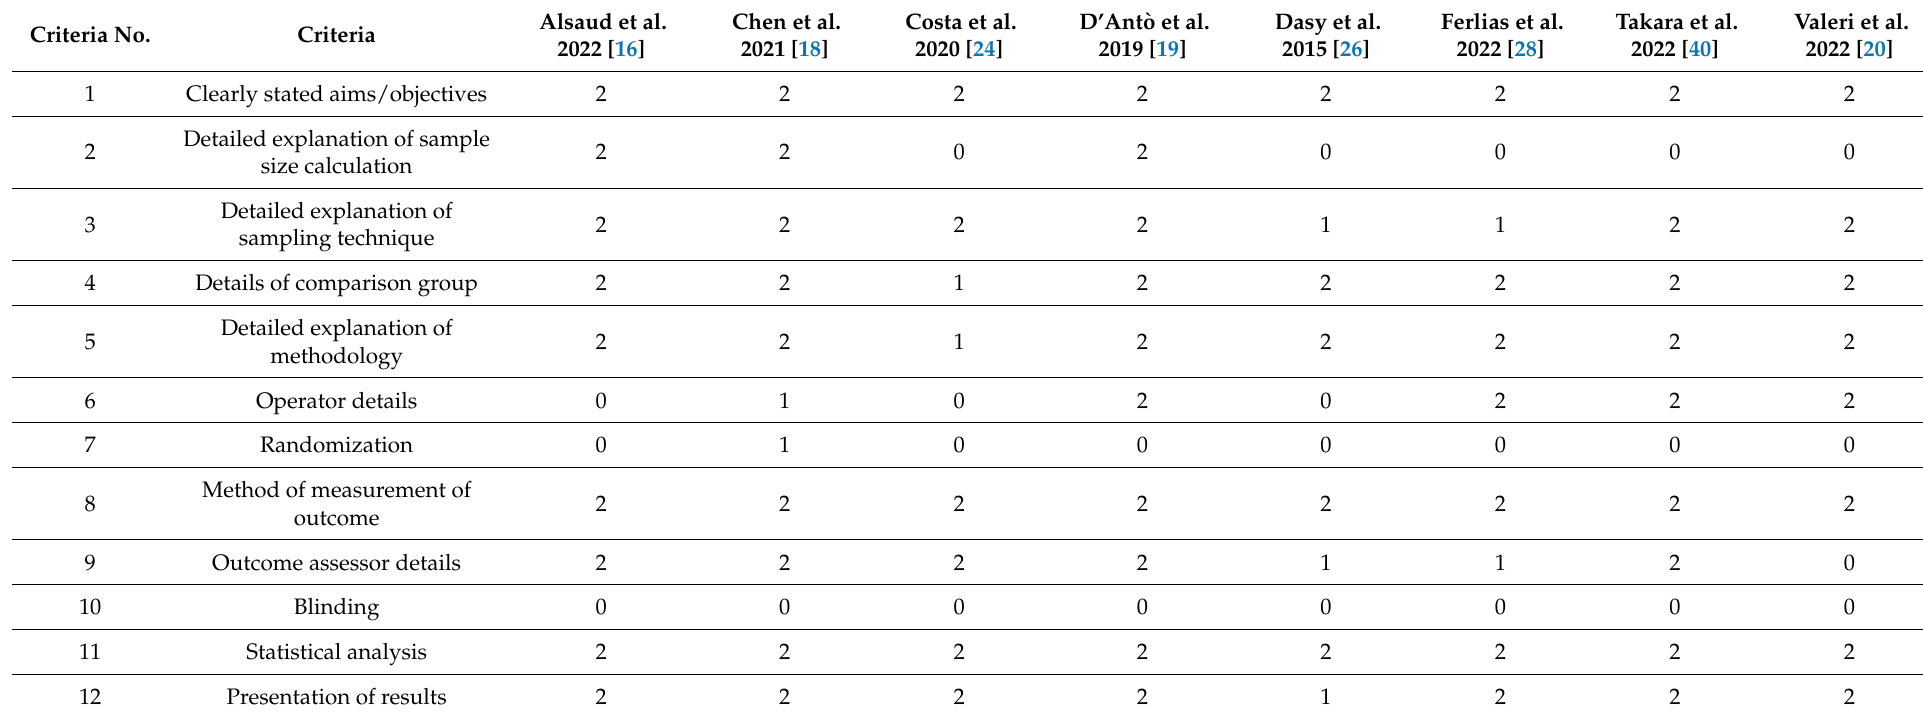
Table 4. Quality assessment of in vitro studies according to QUIN assessment tool. Criteria